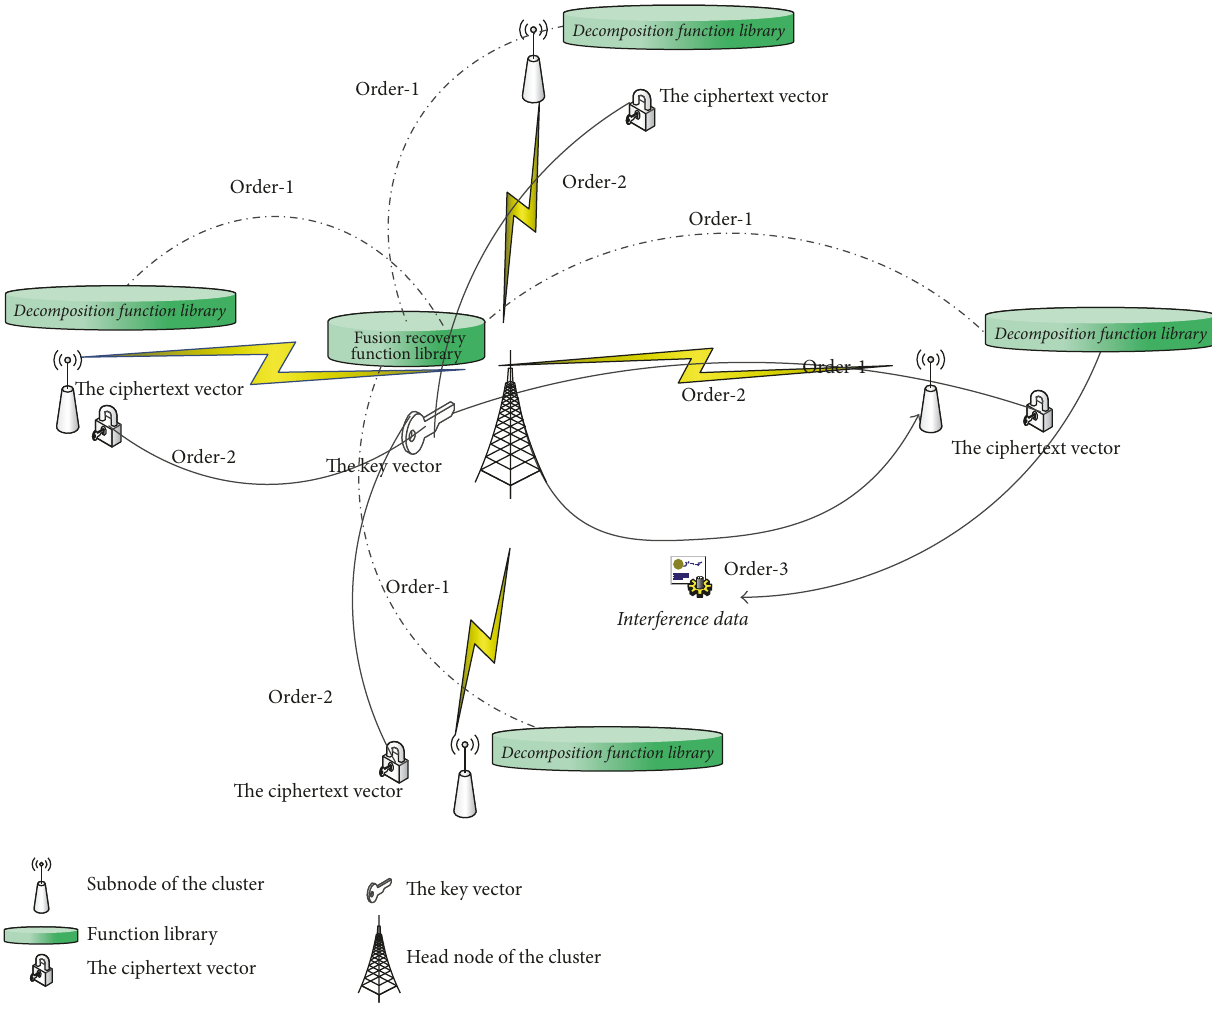
Figure 1: MOFDP model based on cluster